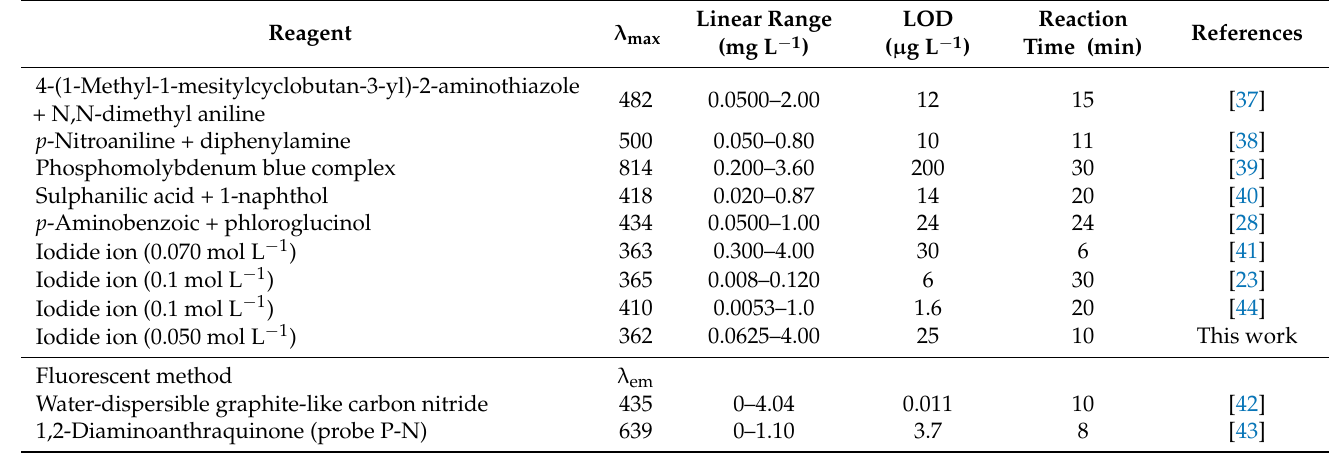
Table 1. Comparison of the analytical performance of previously reported methods and the developed spectrophotometric method for the determination of nitrite ions. Linear Reagent λ max